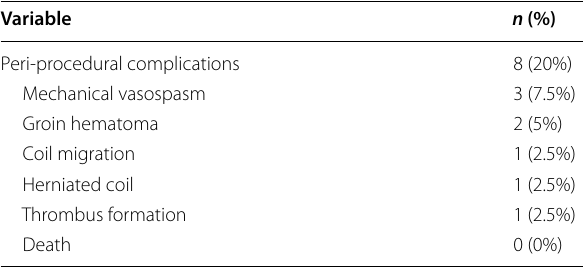
Table 2 Summary of peri‑procedural